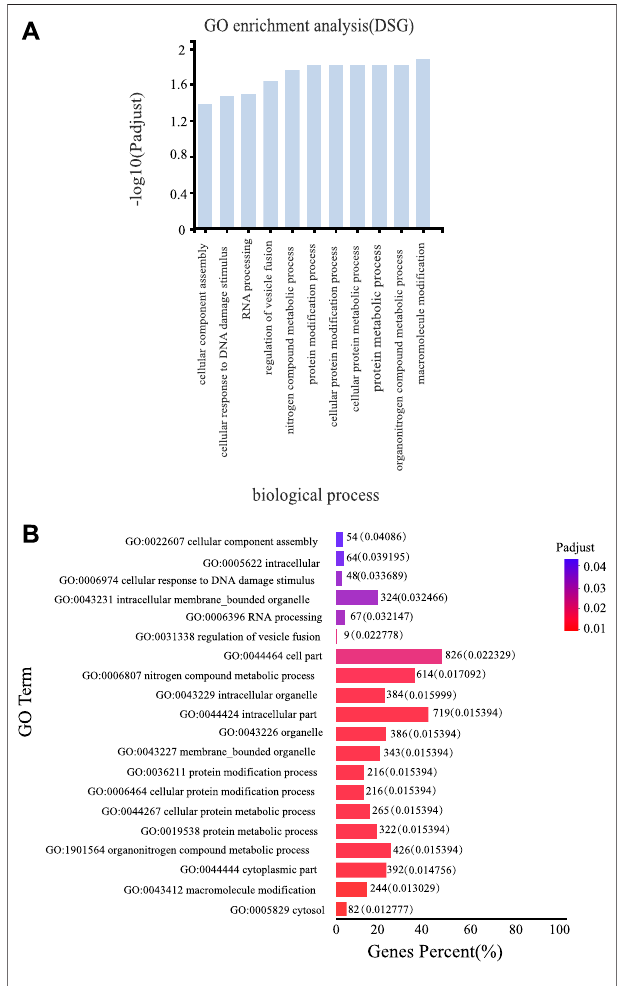
FIGURE 5 | Gene Ontology (GO) analyses of DSGs. (A) GO terms in the biological process and cellular component categories assigned to DSGs undervariousdroughtconditions[falsediscoveryrate(FDR)values < 0.05]. (B) Top 20 GO terms (molecular function) enriched with DSGs under different drought conditions. Note: Histograms represent the percentage of genes (%) for GO